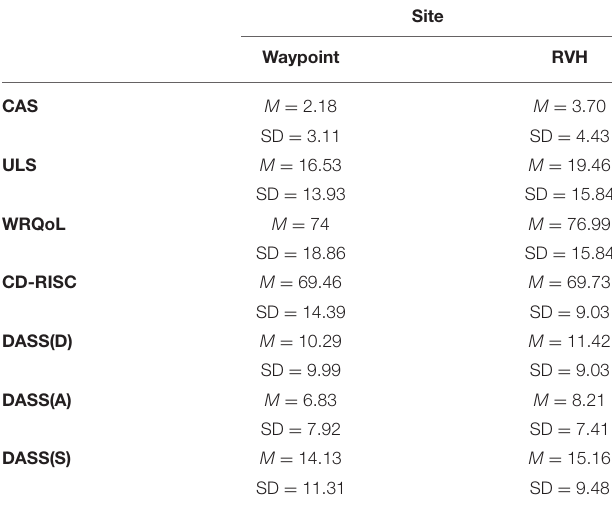
TABLE 3 | Psychometric scale